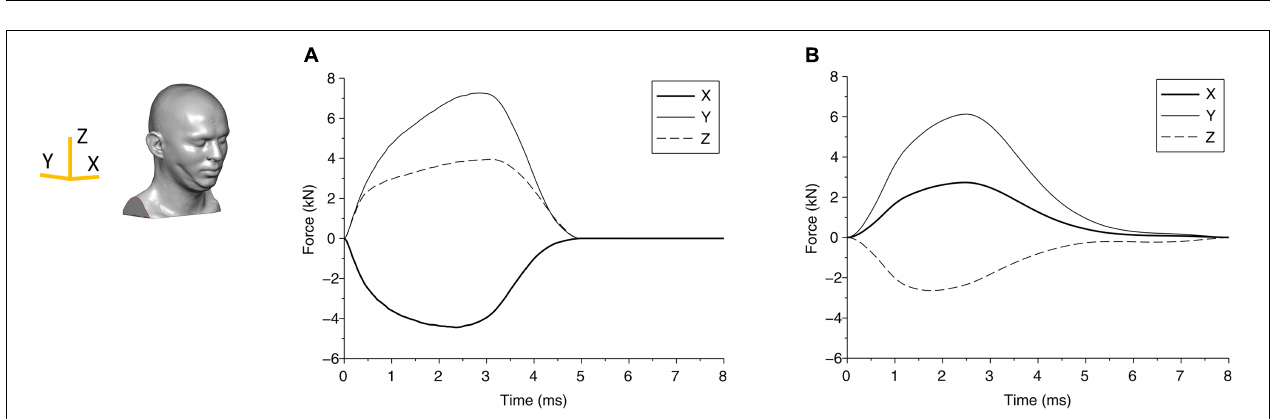
FIGURE 2 | Simulation results showing the biodynamics of the fall, resulting in blunt impact to the head: (A) head position just before hitting the ground, (B) head with initial velocities hitting hemispherical object and rotating about T1, and producing the forces and the moments applied to the head and neck, (C) head hitting hemispherical object of radius 15 mm (in blue) in case 1, (D) head hitting hemispherical object of radius 60 mm (in blue) in case 2.